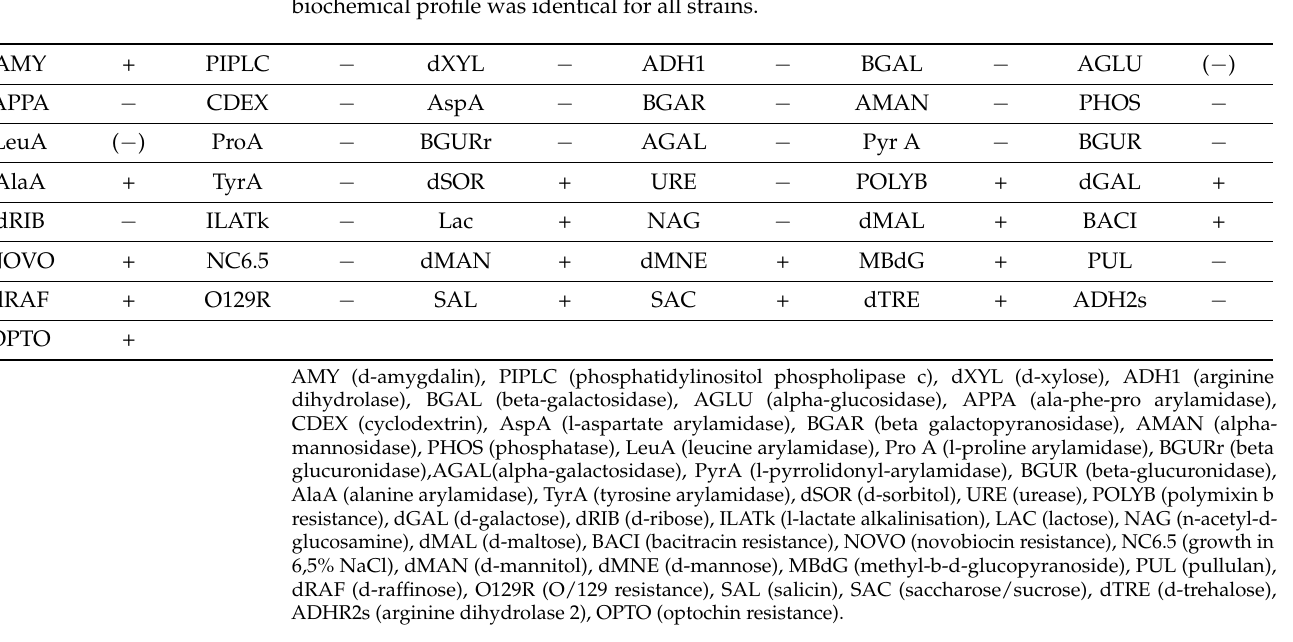
Table 3. Illustrative biochemical profile of S. mutans (GP card) of a randomly selected strain. The biochemical profile was identical for all